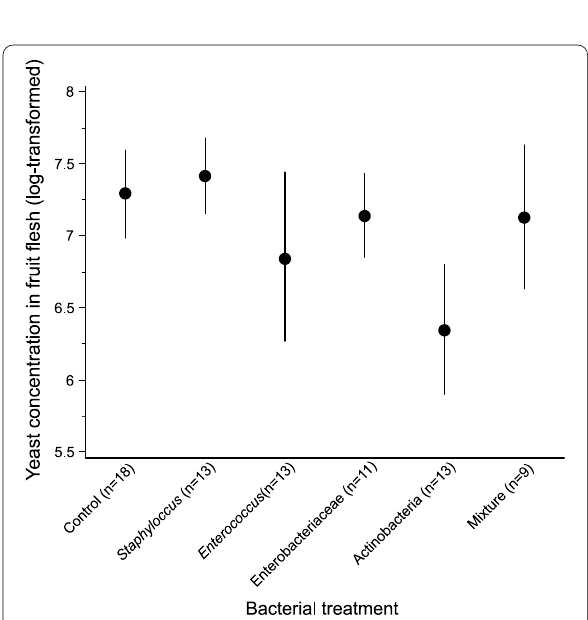
Fig. 2 Yeast concentration in grape berry flesh after the formation of the last pupa. Concentration is expressed in number of yeast cells per 200 µl of fruit flesh. Symbols indicate mean mean